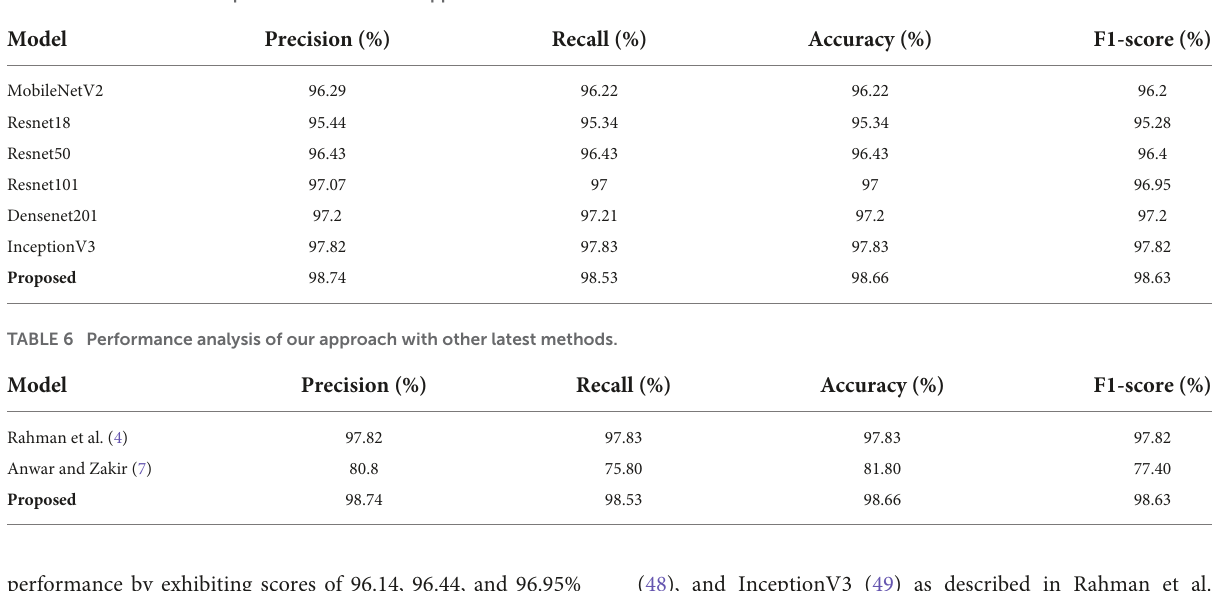
TABLE 5 Performance comparison with DL-based approaches.